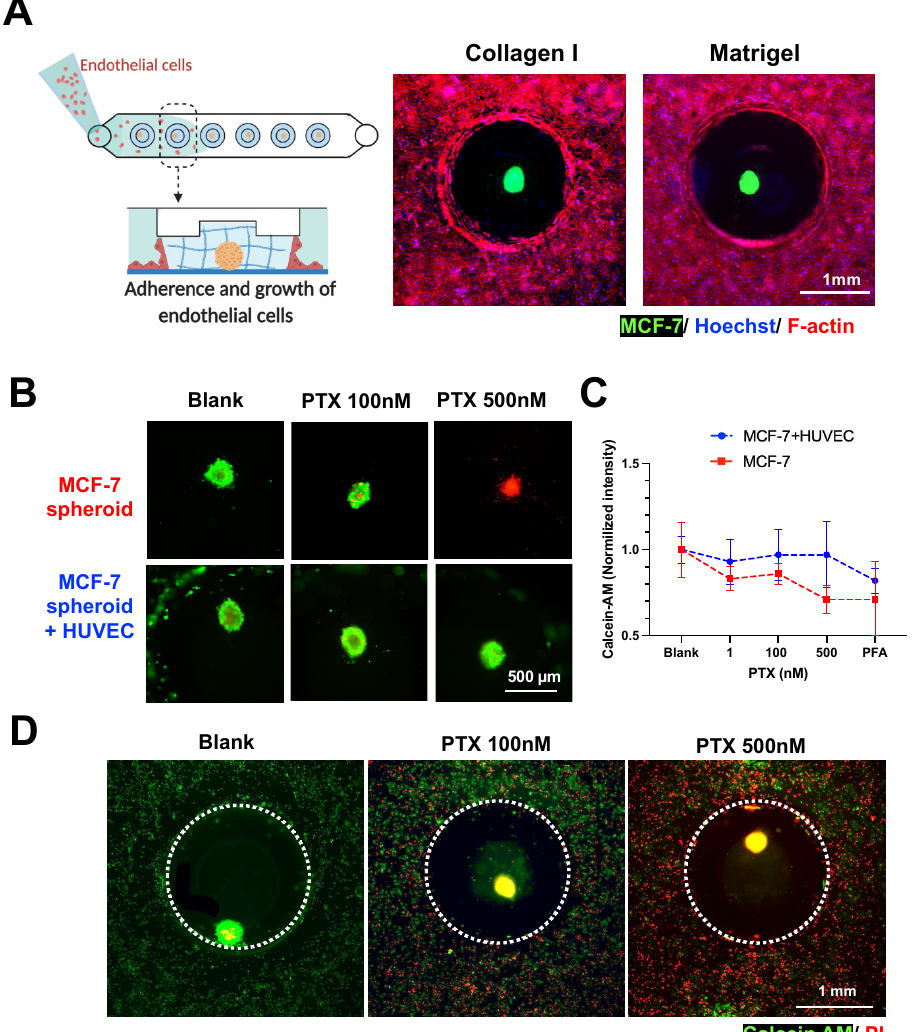
Figure 5. Spheroid-in-gel formation and co-culture with endothelial cells. ( A ) Co-culture of MCF-7 spheroids with endothelial cells (HUVEC) in collagen and Matrigel. MCF-7 was labelled with DiO, F-actin—red, and Hoechst—blue. Schematics were created with BioRender.com. ( B ) Merged fluorescent images illustrating viability of spheroid after PTX treatment. (Calcein-AM—green and PI—red) ( C ) Normalized fluorescence intensity of Calcein-AM for spheroids with or without HUVEC co-culture after 3 days of treatment with PTX 1, 100, and 500 nM. A PFA-fixed spheroid was used as negative control. Data are presented as the mean ± SD. ( n = 3) ( D ) Merged fluorescent images illustrating viability of spheroids and HUVEC in co-culture after 3 days of PTX treatment. (Calcein-AM—green and PI—red).